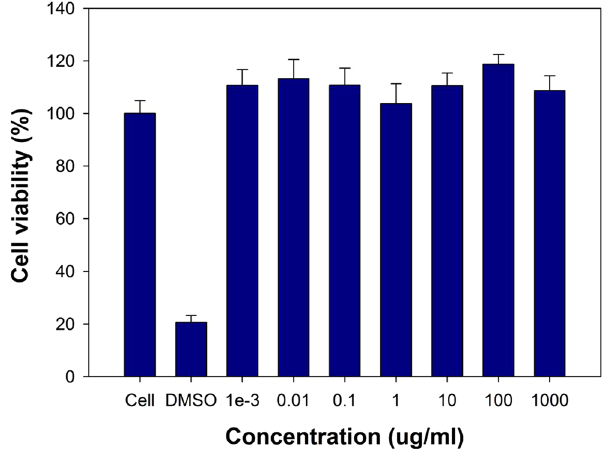
Figure 4. Cytotoxicity of MHI-DSPE-SPION analysed using NIH3T3 cells, as quantified by MTS assay. Mean cell viability of NIH3T3 was used for MTS assay in quadruplicate samples ± SD.